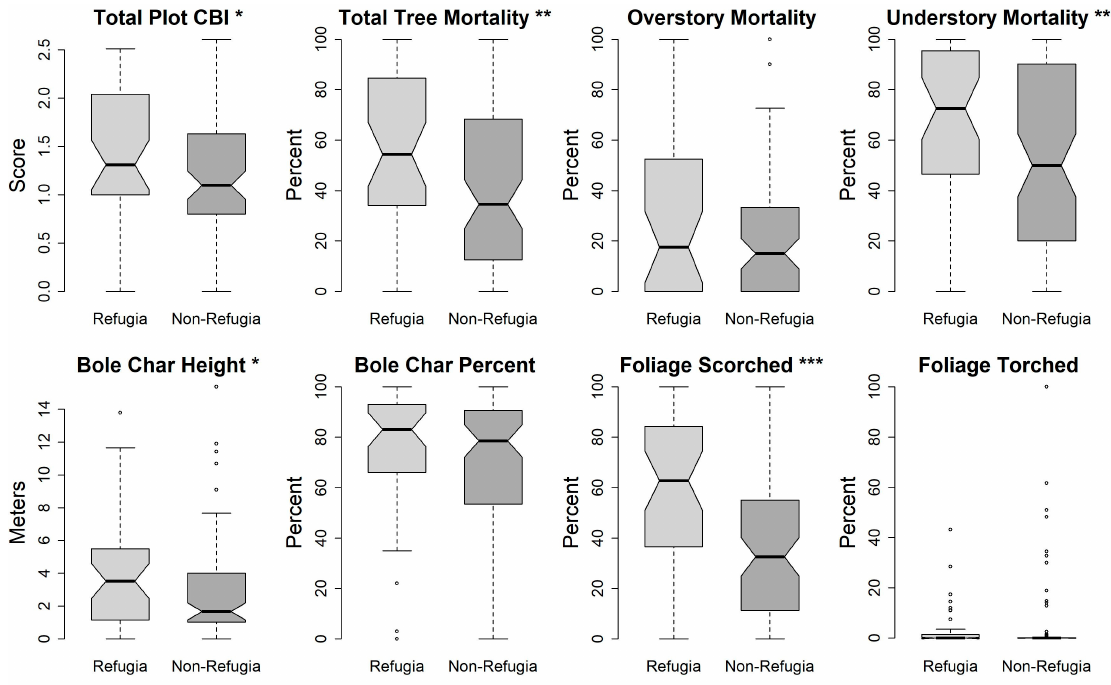
Figure 4. Comparison of fire effects between Camp et al. [11] refugial and non-refugial plots for eight different burn severity metrics. * p ≤ 0.10, ** p ≤ 0.05, *** p ≤ 0.01.